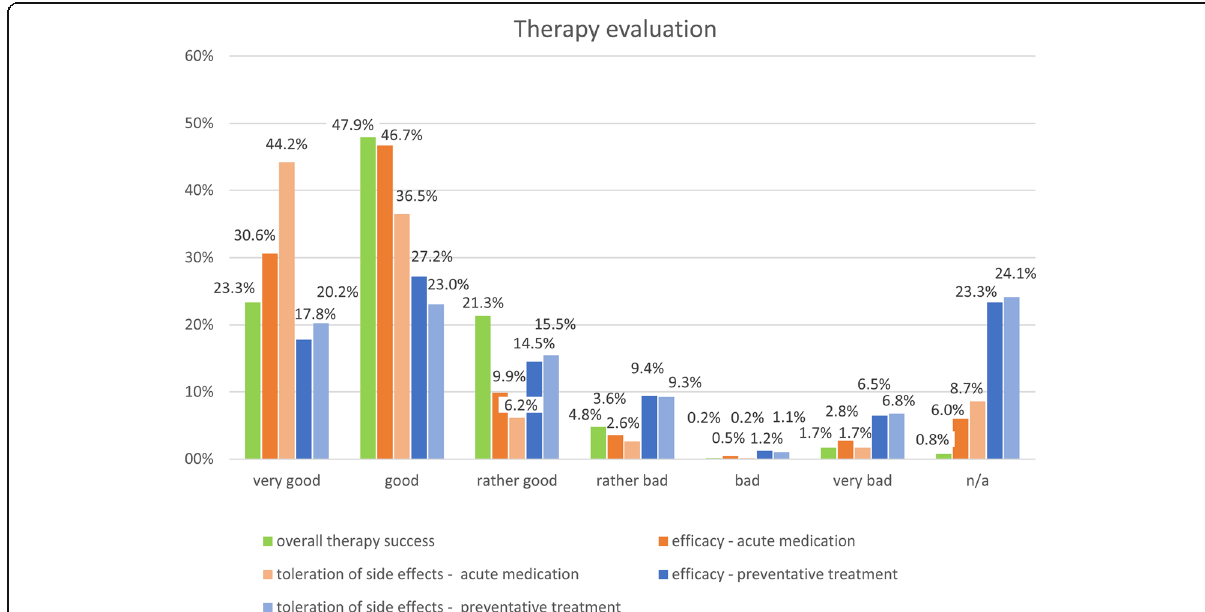
Fig. 2 Therapy evaluation of migraine patients presenting for a second time to the out-patient clinic. Clinicians ’ evaluation of overall success as well as evaluation of acute and preventative treatment regarding efficacy and tolerability. ( n = 647). n/a: not